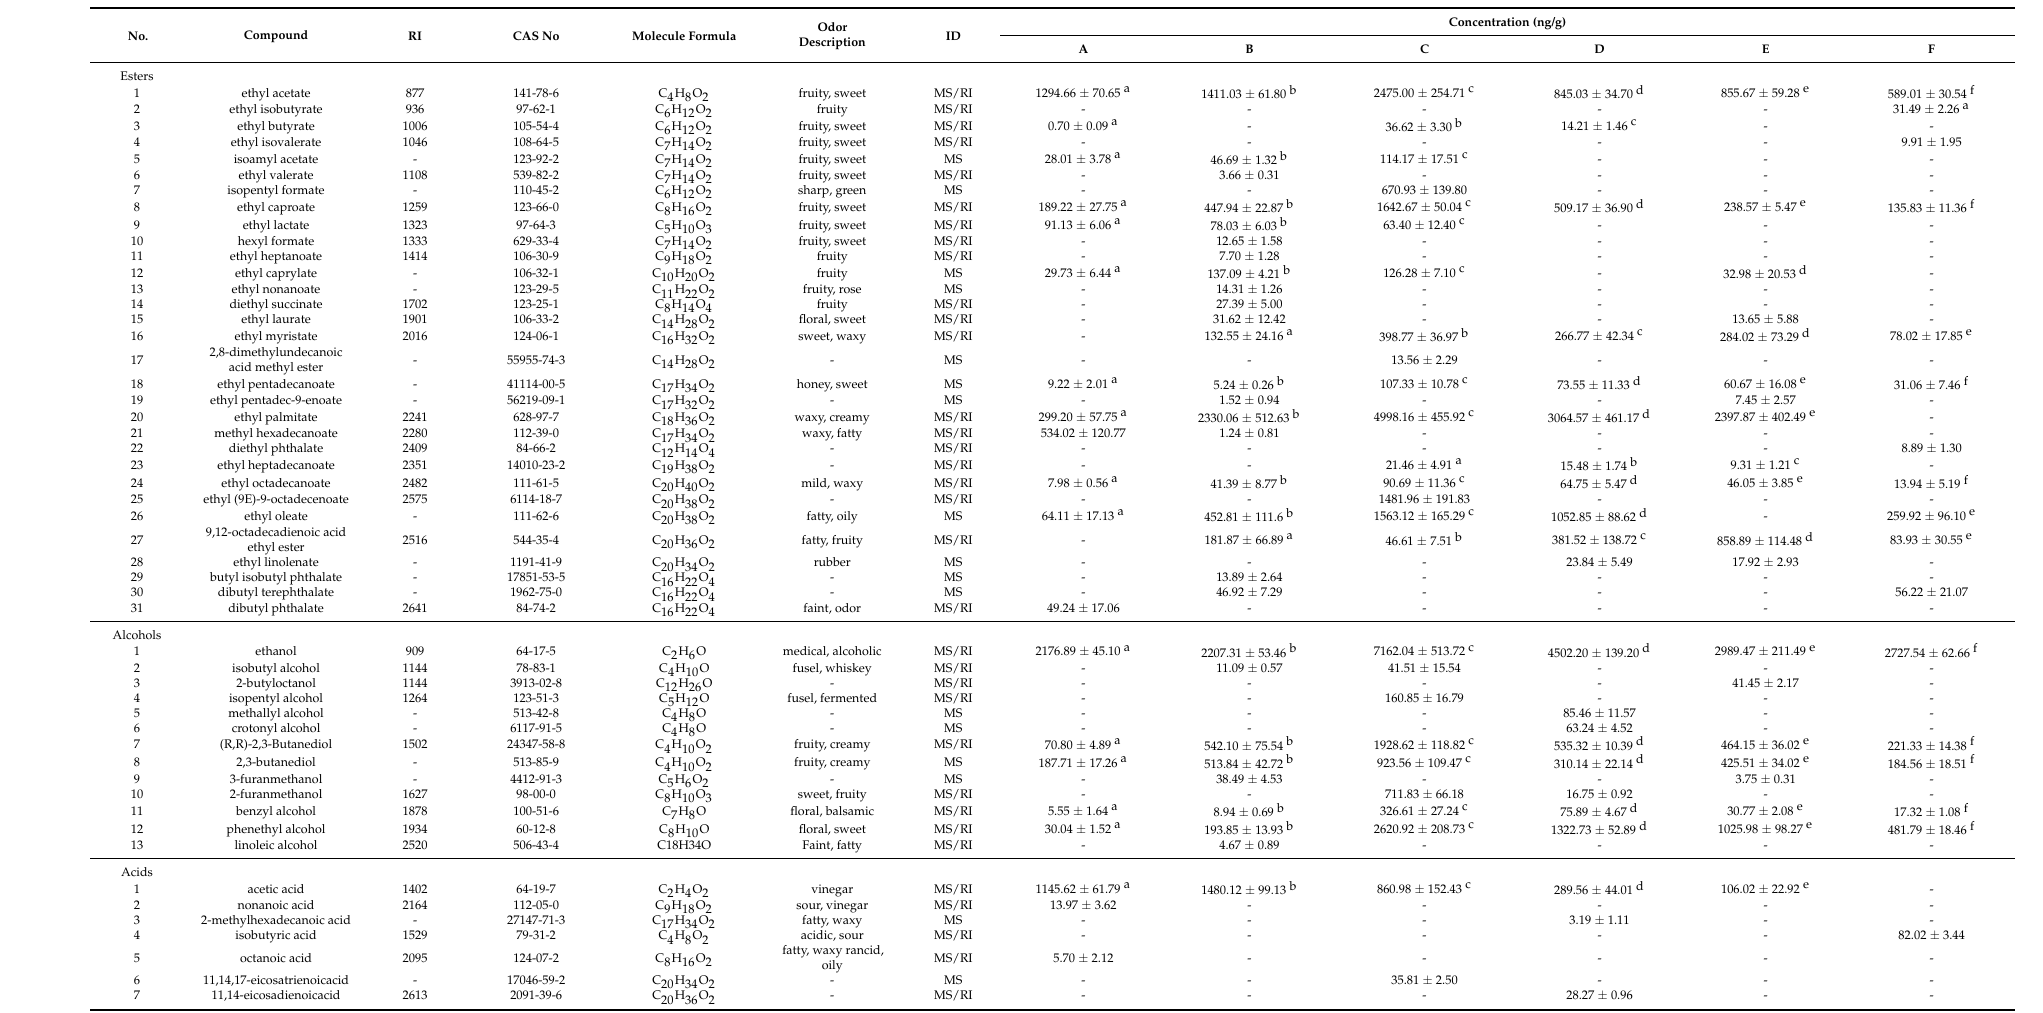
Table 1. Volatile compounds identified by HS-SPME-GC-MS in